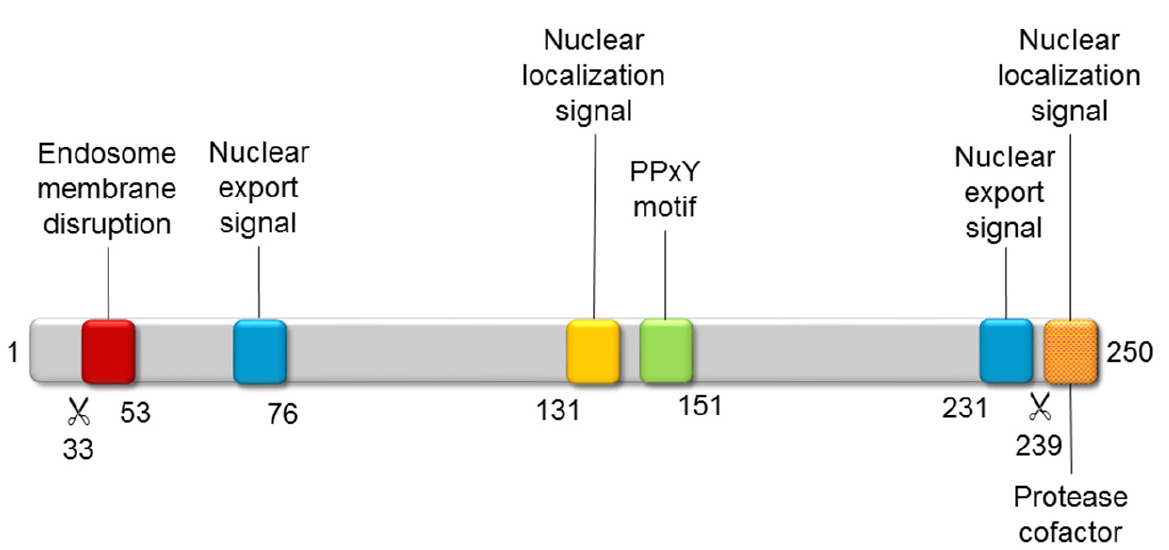
Figure 4. Functional motifs of polypeptide VI. The adenoviral protease (AVP) cleavage sites (scissor symbol) and the position of some residues are indicated below the gray bar representing the precursor polypeptide VI polypeptide